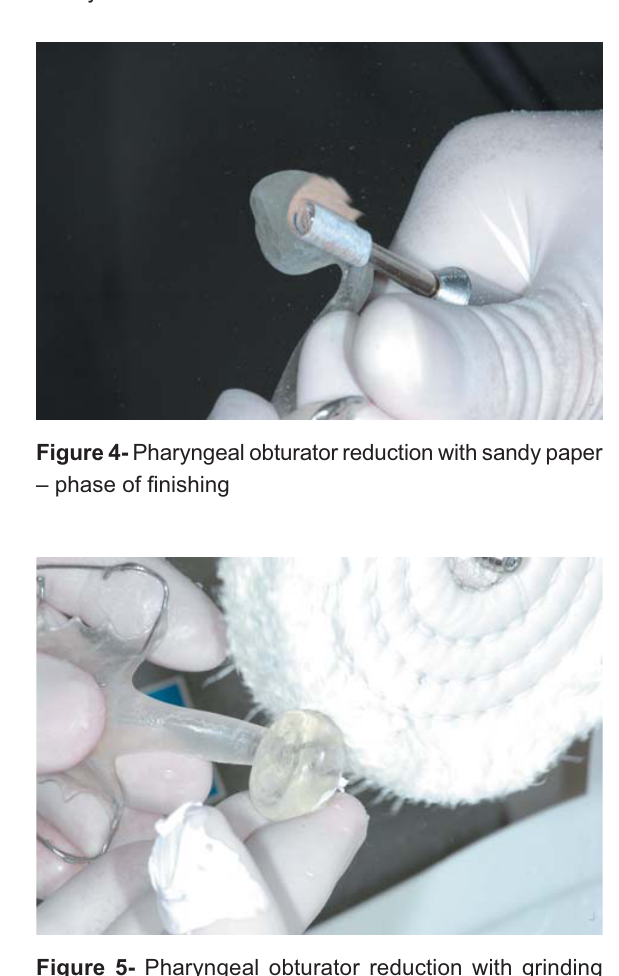
Figure 3- Pharyngeal obturator reduction with bur – phase of fray